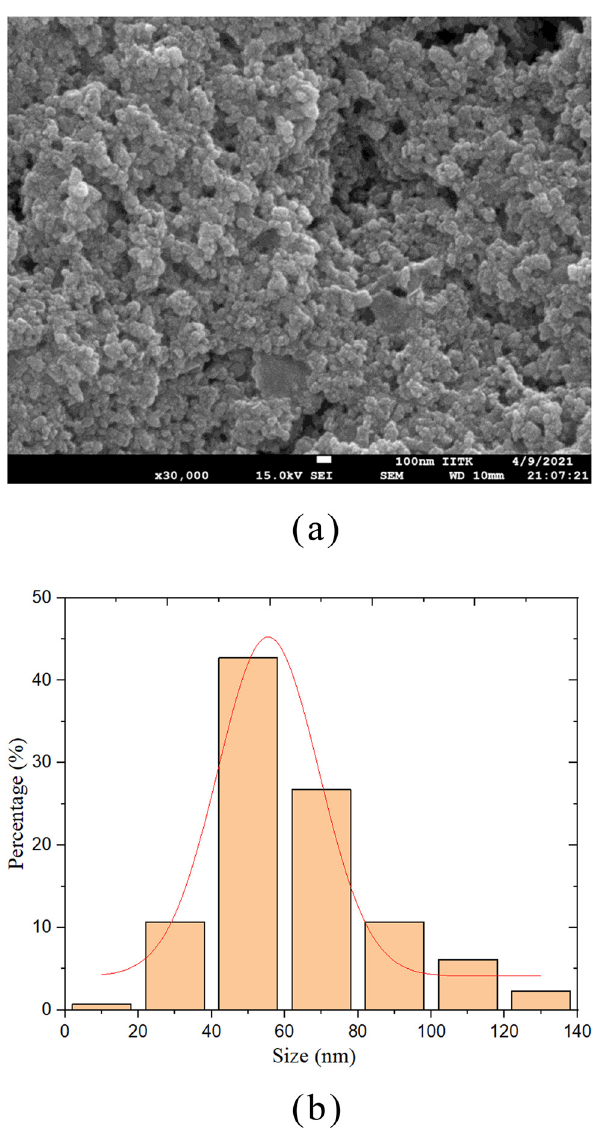
Figure 4: ( a ) FESEM image of biosynthesized ZnO NPs. ( b ) Particle size distribution histogram of ZnO NPs.